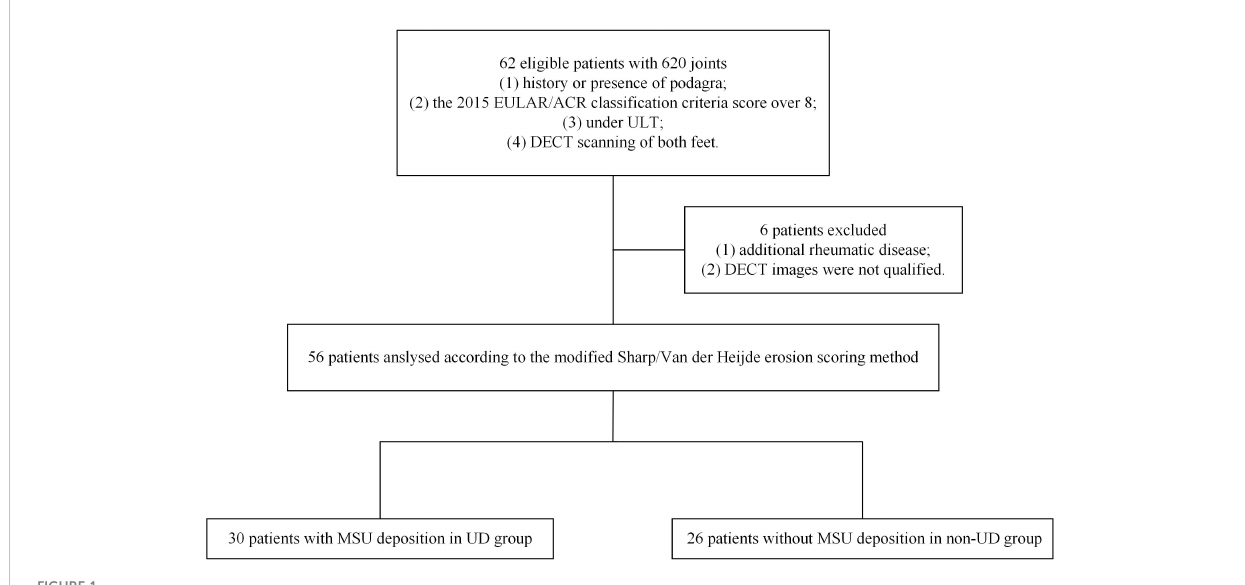
FIGURE 1 Flowchart illustrating the selection of patients and joints. DECT, dual-energy computed tomography; EULAR/ACR, European League Against Rheumatism/American College of Rheumatology; MSU, monosodium urate; UD, urate deposition; ULT, urate-lowering